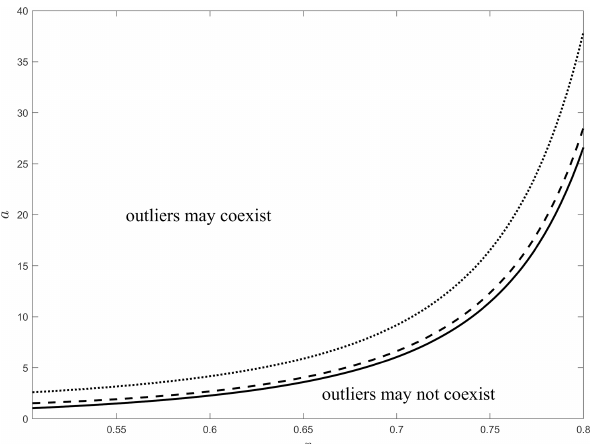
Figure 7. Critical curve a crit ( r ) on the [ r , a ] parameter plane. Sys- tems with parameters ( r , a ) associated with points above the curve permit the coexistence of outliers, while the systems associated with points below the critical curve do not permit the coexistence of out- liers. The solid line belongs to the N → ∞ limit, the dotted line represents N = 20, and the dashed line N = 100